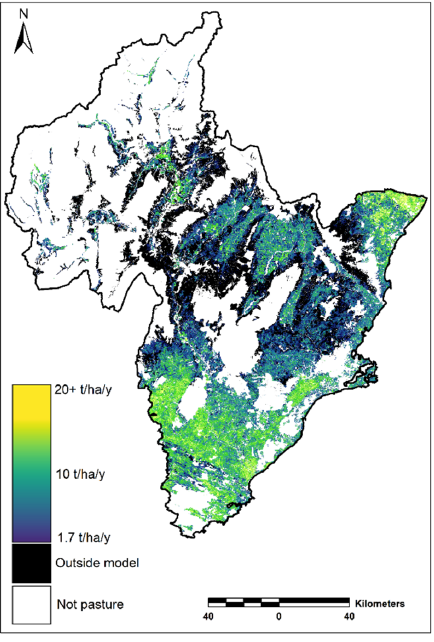
Figure 8. Otago pasture yield, with black areas having lower productivity than can be predicted by this model.